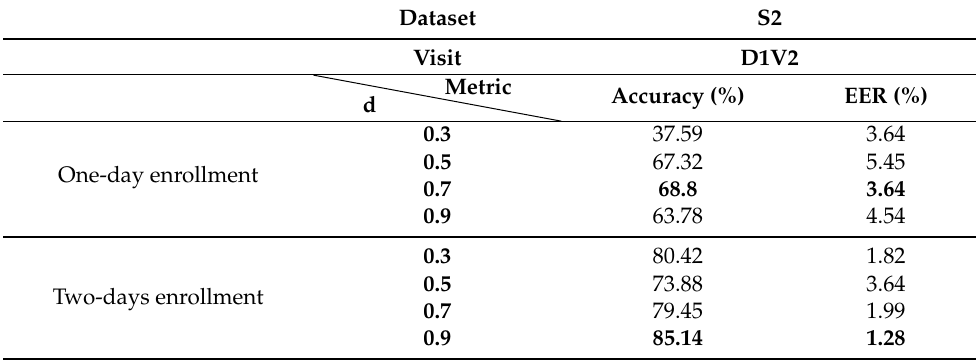
Table 6. Identification and verification results for scenario S. The best considered options for one-day and two-days enrollment are in bold font.